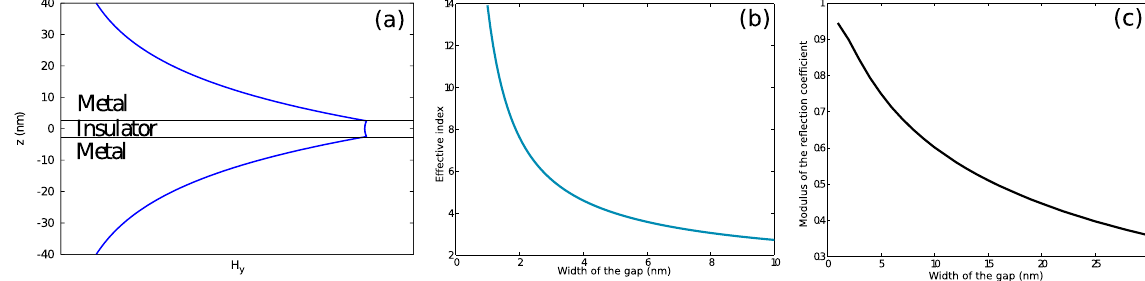
Figure 2. ( a ) Profile of the magnetic field associated with the gap-plasmon propagating along the x axis. ( b ) Effective index α R